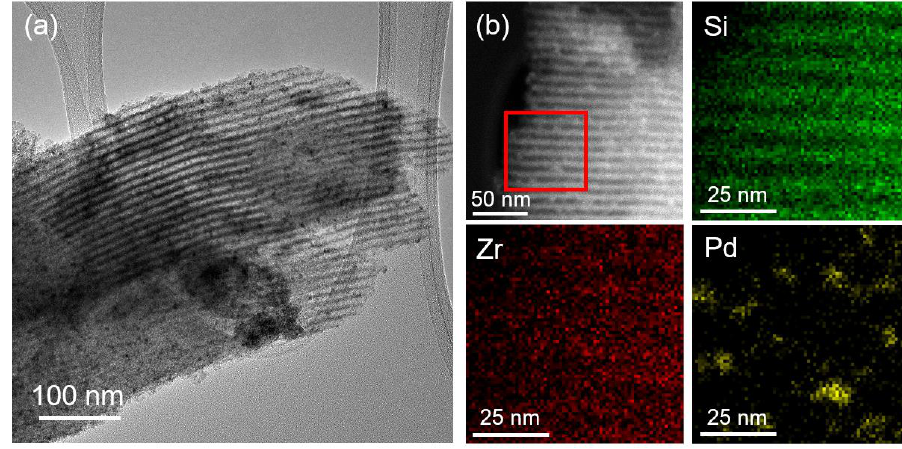
Figure 8. Representative ( a ) TEM and ( b ) STEM images with EDS maps of Pd/ZrO 2 /SBA-15.